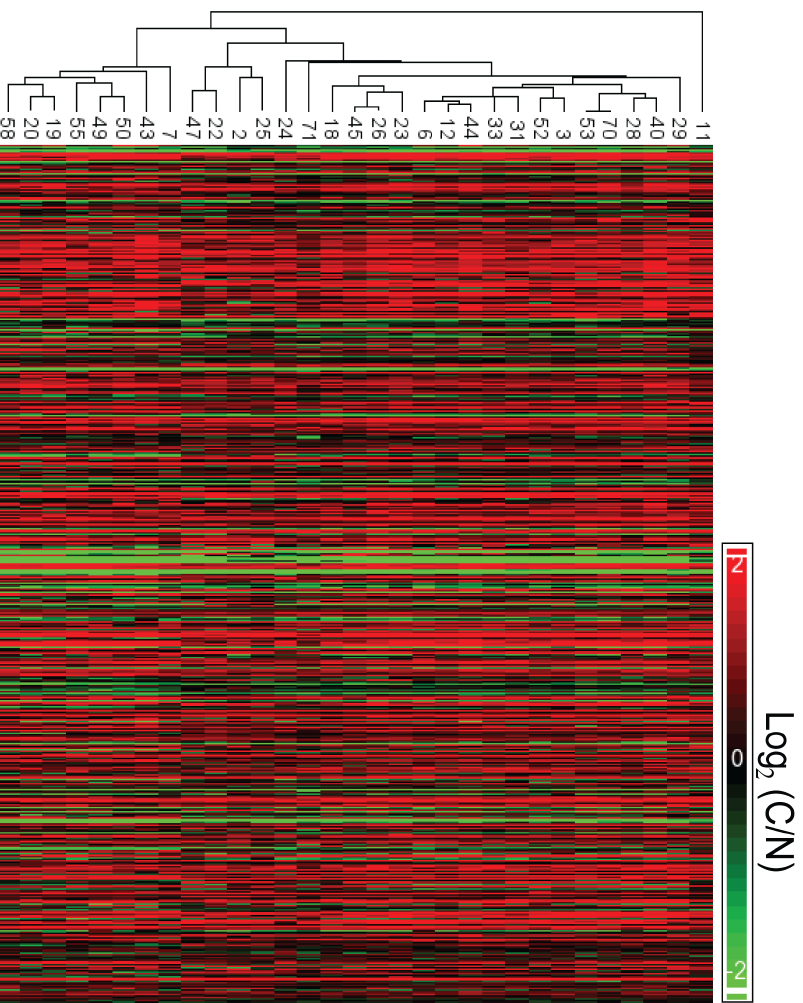
Figure 4. Heatmaps reveal heterogeneity between all 31 mice. Transcripts that were changed at least four-fold according to the average analysis are displayed with their expression level in each mouse separately. Although the mice can be clustered into closely related groups, no two mice show exactly the same expression pattern.